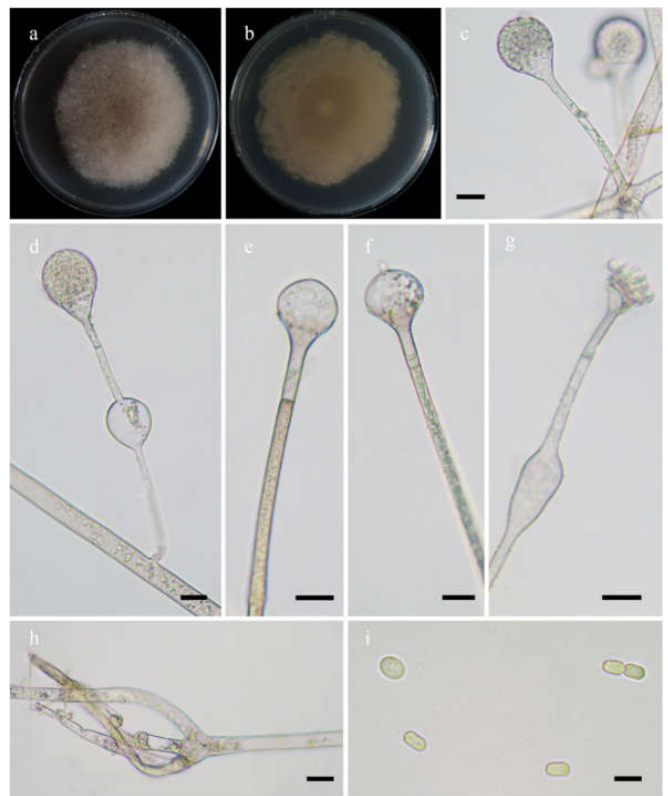
Figure 7. Morphologies of Absidia yunnanensis ex-holotype CGMCC 3.16259. ( a , b ). Colonies on MEA (( a ), obverse, ( b ), reverse); ( c ), sporangia; ( d ), swellings below sporangia; ( e – g ), columellae; ( h ), rhi-